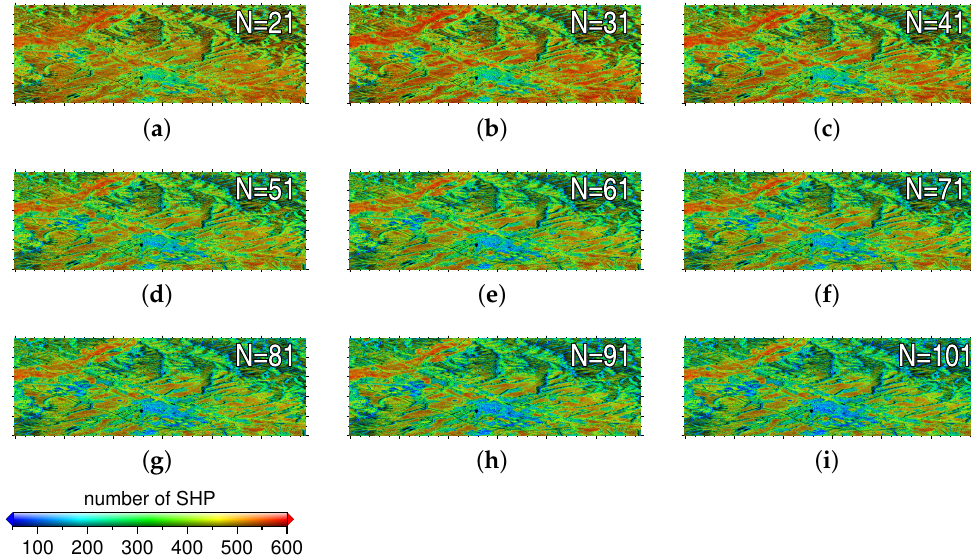
Figure 4. The number of SHP maps overlaid on the average SAR amplitude under a stack dimension of 21 ( a ), 31 ( b ), ..., 101 ( i